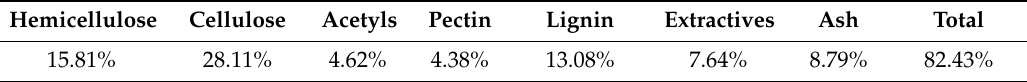
Table 3. Chemical composition of Cynara cardunculus stem.